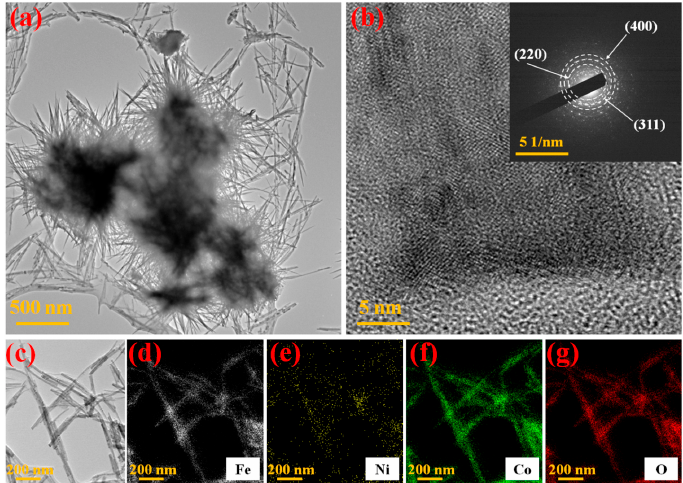
Figure 3. Fe-dopant@NiCoO x @NF nanoneedle composite sample: ( a ) TEM images, ( b ) HRTEM images (inset; SAED of the sample), and ( c – g ) TEM-EDS mapping of Fe, Ni, Co, and O.